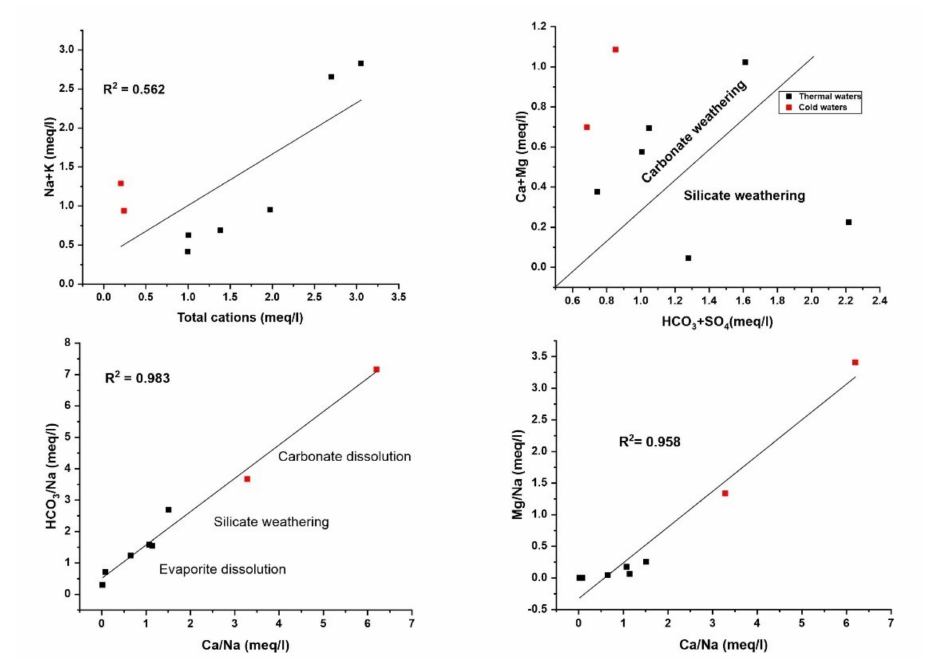
Figure 12. Scatter plots of the study area explaining silicate weathering and carbonate dissolution.